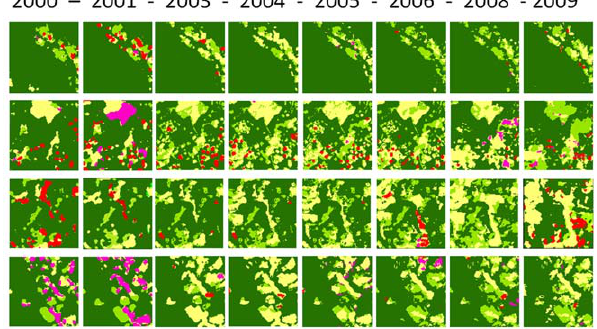
Figure 2. Land use changes during the period of analysis in four of the 291 windows (3 km 6 3 km), one of each mosaic type. A, Forest mosaics; B, Pasture mosaics; C, Fire mosaics; and D, Illicit crop mosaics. Forest (dark green), secondary vegetation (light green); pastures (yellow), burned area (red); illicit crops (purple).